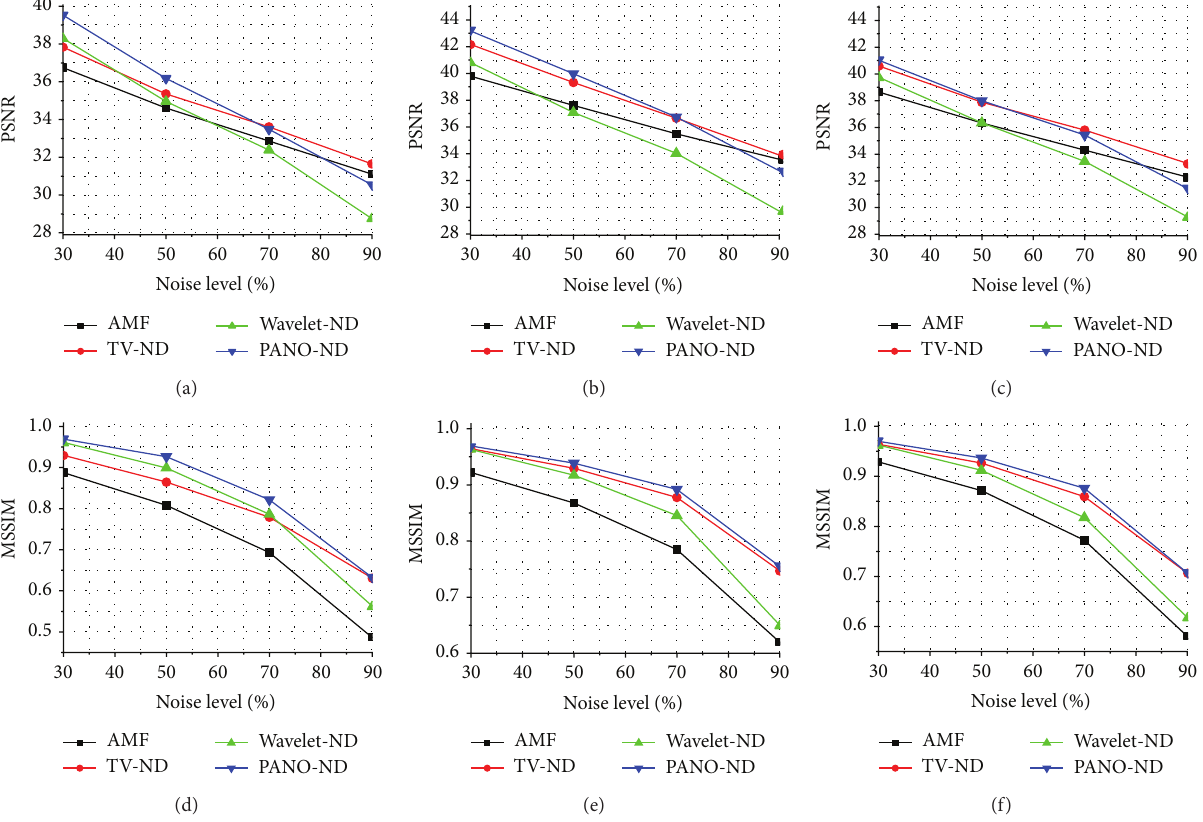
Figure 7: Quantitative measure at different noise levels. (a)–(c) PSNRs of Barbara , House , and Boat images, respectively; (d)–(f) MSSIMs of Barbara , House , and Boat images, respectively.